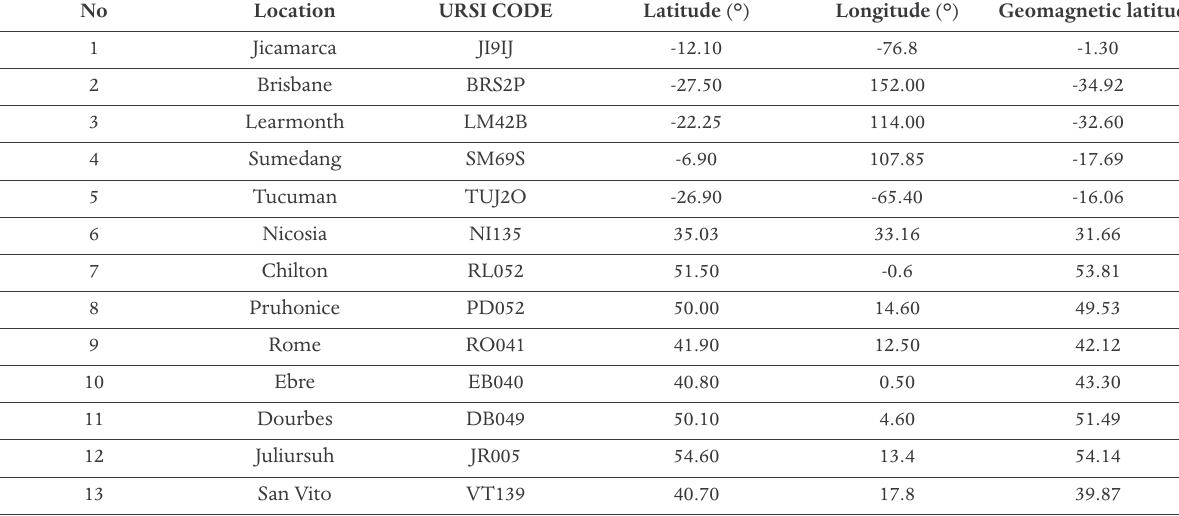
Table 3. List of ionosonde stations used for the evaluation of